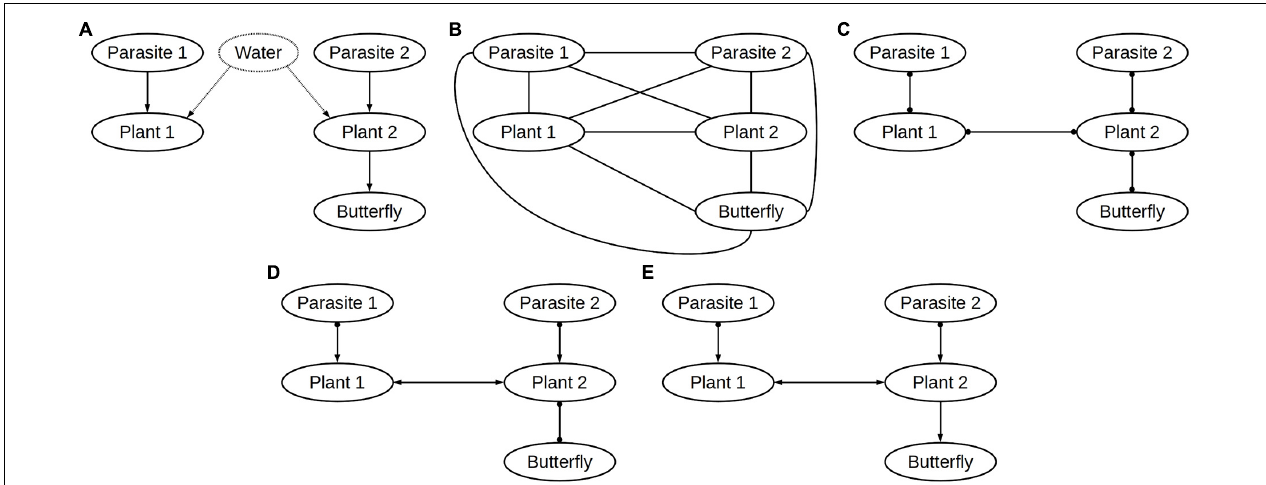
FIGURE 1 | Schematic illustration of the Fast Causal Inference (FCI) algorithm for a system consisting of five measured variables—the performance of two parasite species, two plant species and one butterfly species—and one hidden variable—water. (A) The true underlying causal network in which water has a causal influence on both plant species, the first parasite species influences the first plant species, the second parasite species influences the second plant species, and the second plant species has a causal effect on the butterfly species. (B) The starting network of the skeleton phase in which each node is connected to each other node. (C) The output of the skeleton phase, called the skeleton, in which nodes are connected to other nodes if and only if they cannot be separated by taking into account other variables in the model. (D) The result after the v-structure orientation rule. (E) The final output of the FCI algorithm after the orientation